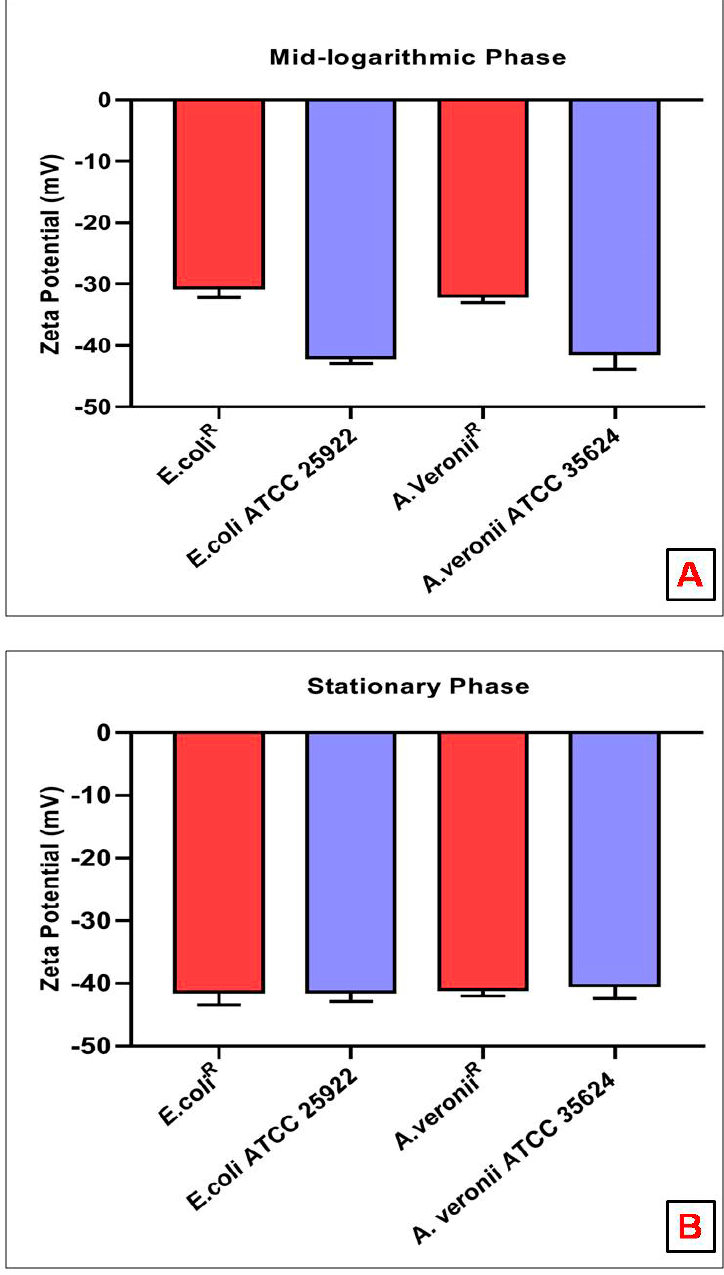
Figure 5. Zeta potential (mean ± SD) of colistin-susceptible and resistant E. coli and A. veronii at ( A ) mid-logarithmic Phase; ( B ) stationary phase. at ( A ) mid-logarithmic Phase; ( B ) stationary